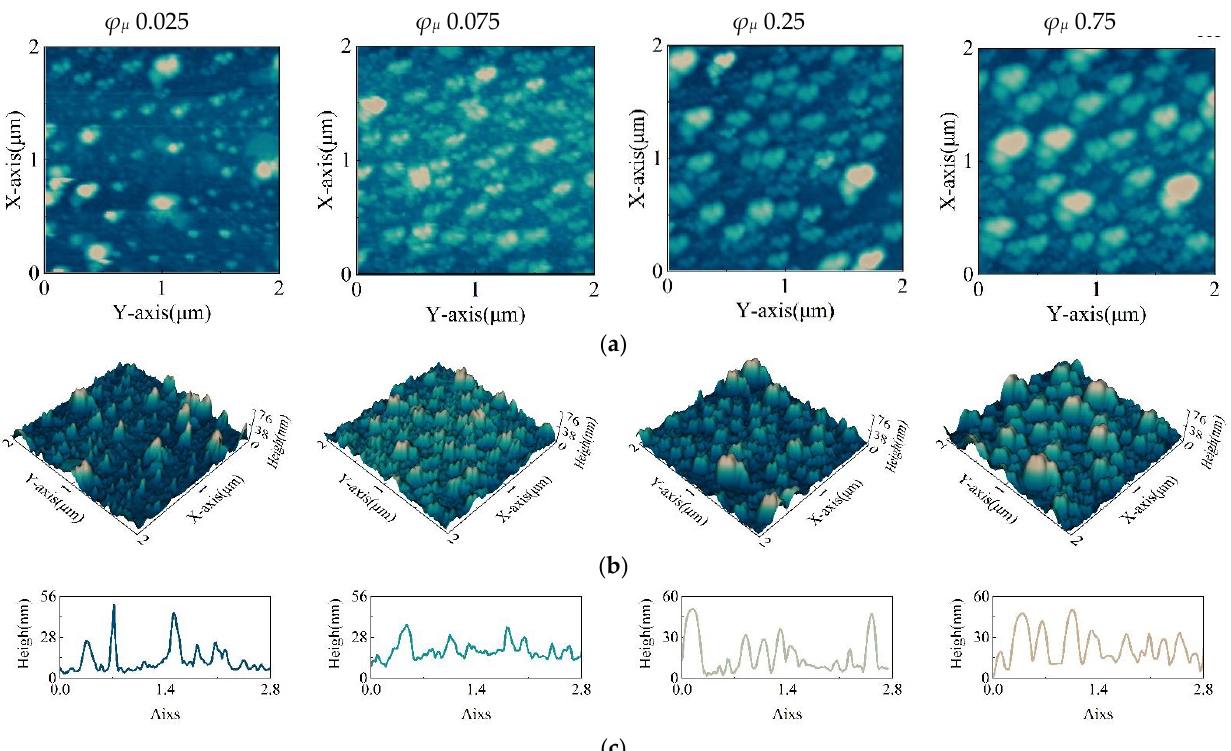
Figure 6. ( a ) Contour map of the film. ( b ) Three-dimensional images of the film under AFM. ( c ) Sectional view of the film’s diagonal. (The volume fractions of ink solute are 0.025, 0.075, 0.25, and 0.75.).